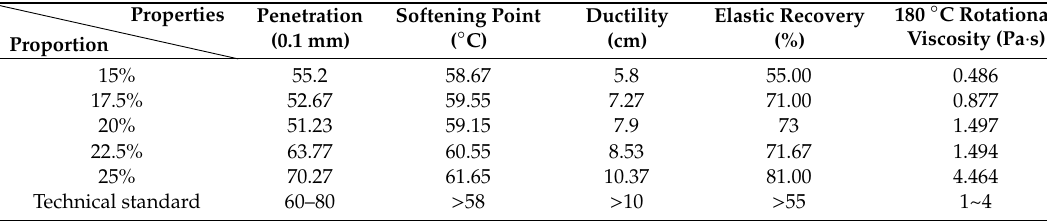
Table 6. Basic physical properties of di ff erent asphalt rubber